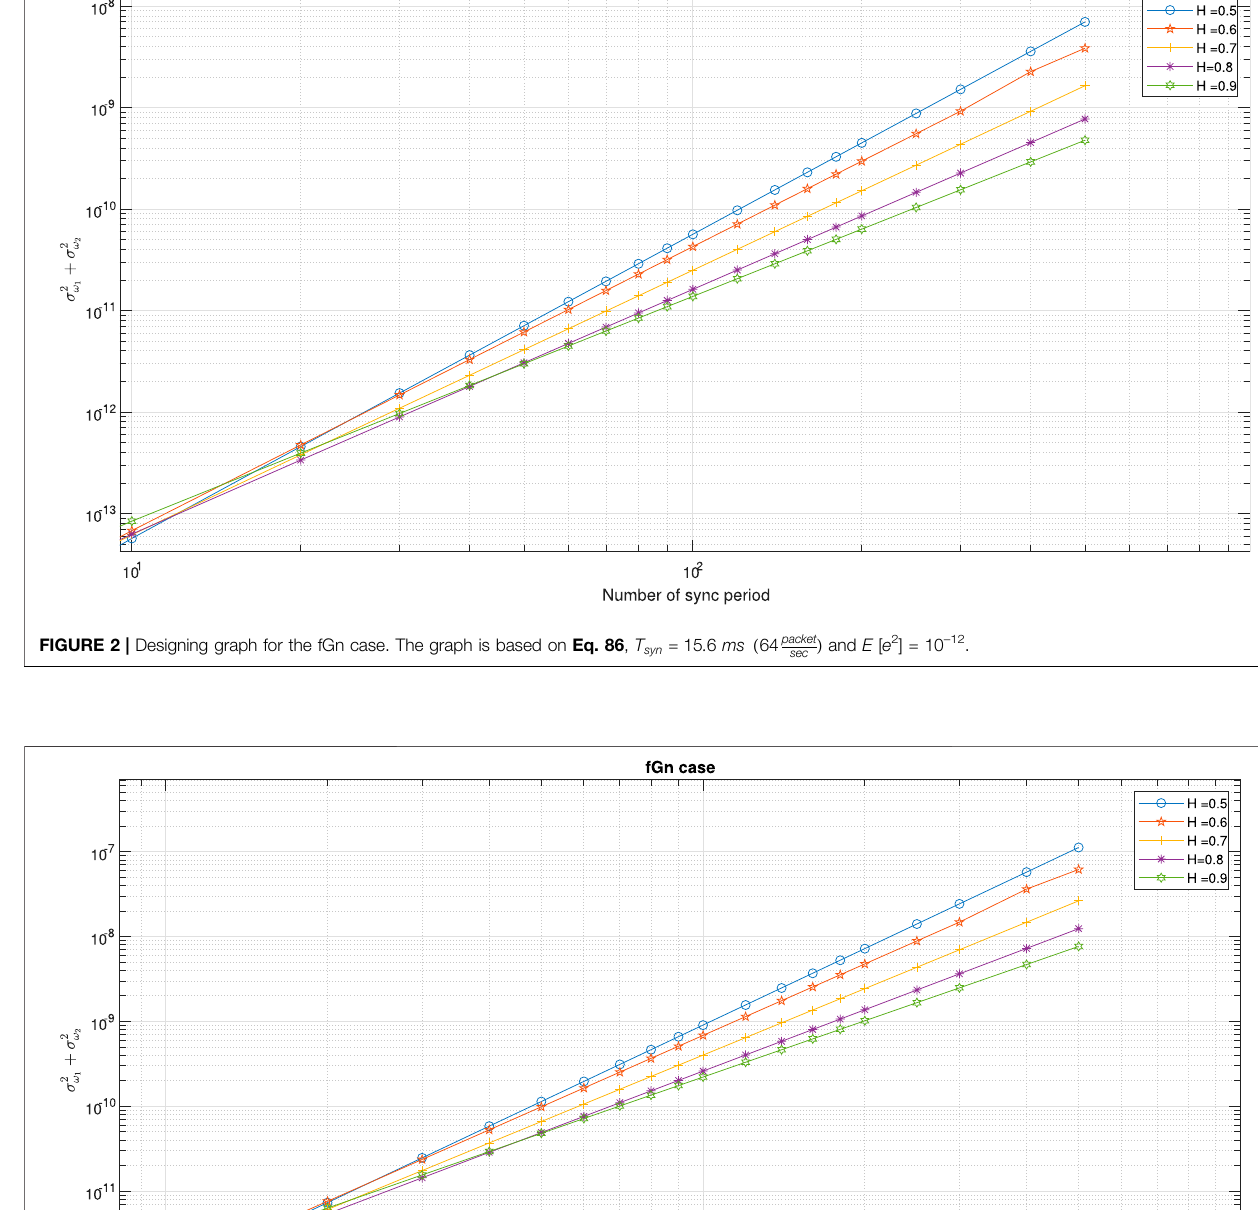
FIGURE 3 | Designing graph for the fGn case. The graph is based on Eq. 86 , T syn (cid:1) 62 . 5 ms ( 16 packet